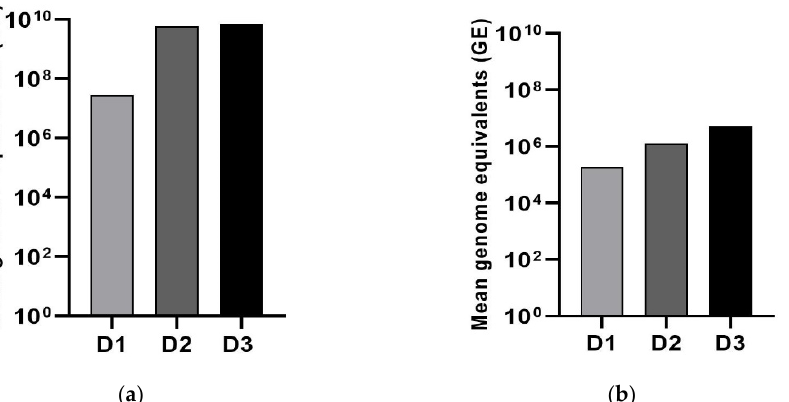
Figure 3. The quantification of LJV following oral administration to adult Ds flies. ( a ) High concentration (LC, 10 6 GE/mL). ( b ) Low concentration (HC, 10 5 GE/mL). T-test analysis revealed no significant differences between the virus load measured on day one compared to day two or three.